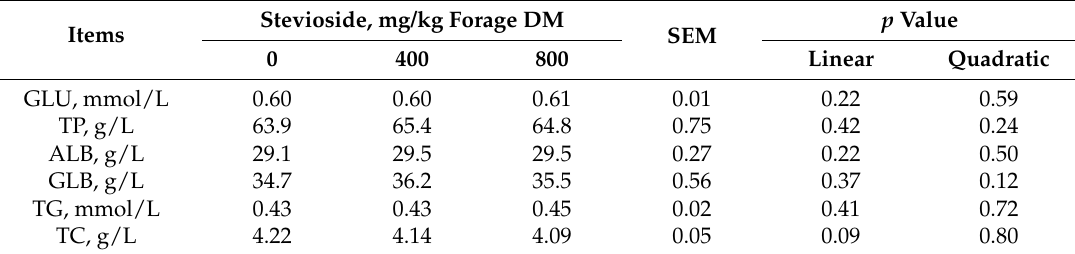
Table 5. Effects of stevioside on serum metabolites in goats